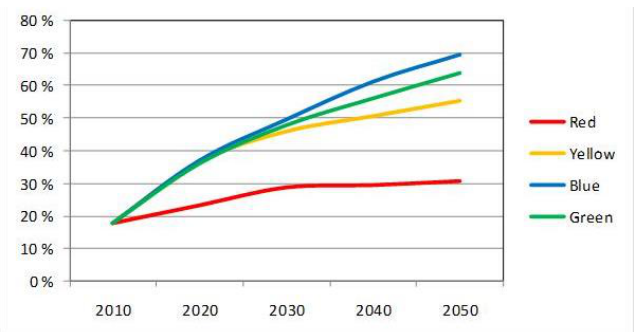
Fig. 6. Share of RES-Electricity on gross demand in all